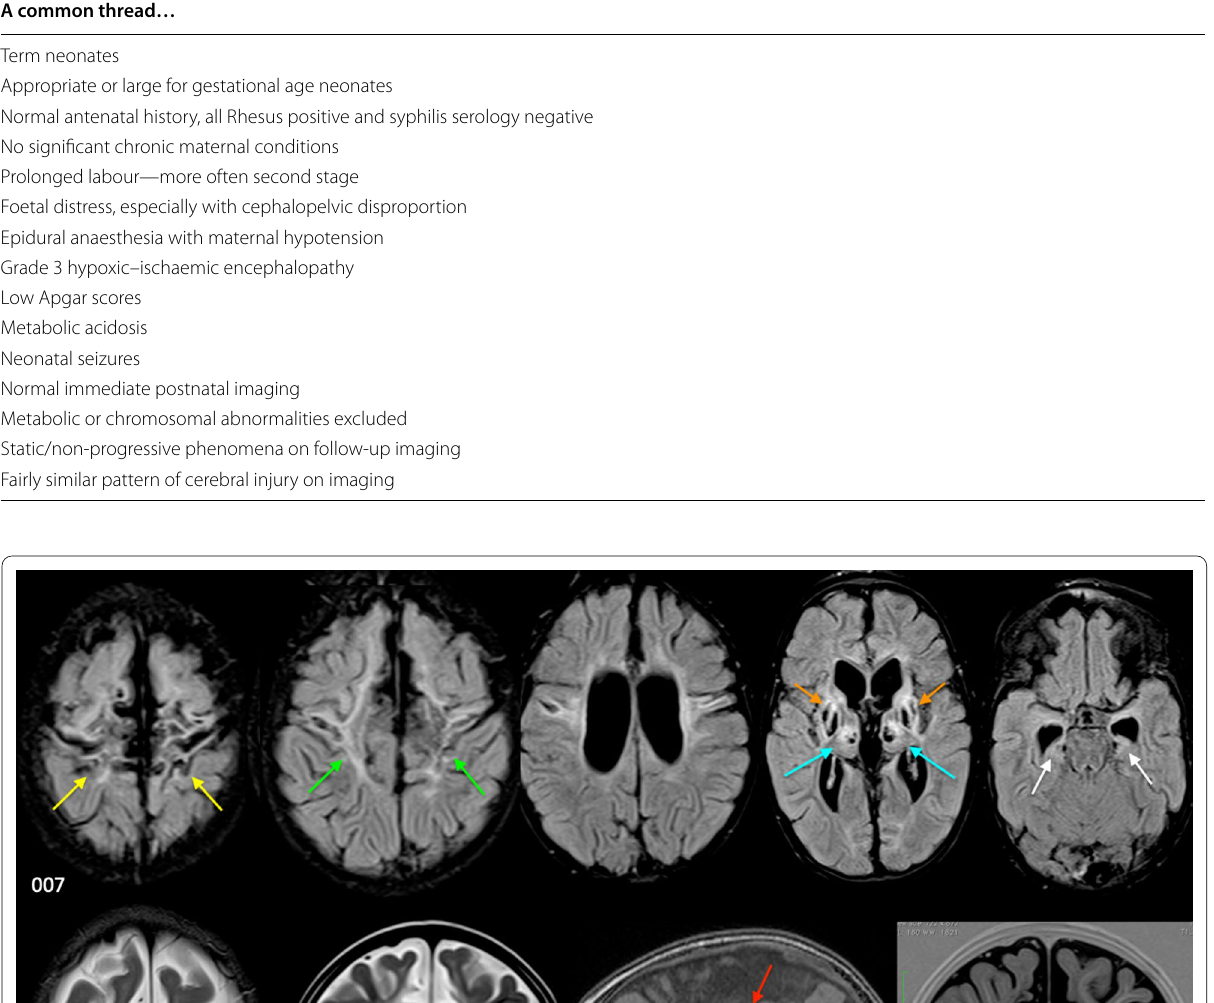
axial FLAIR and bottom row (from =